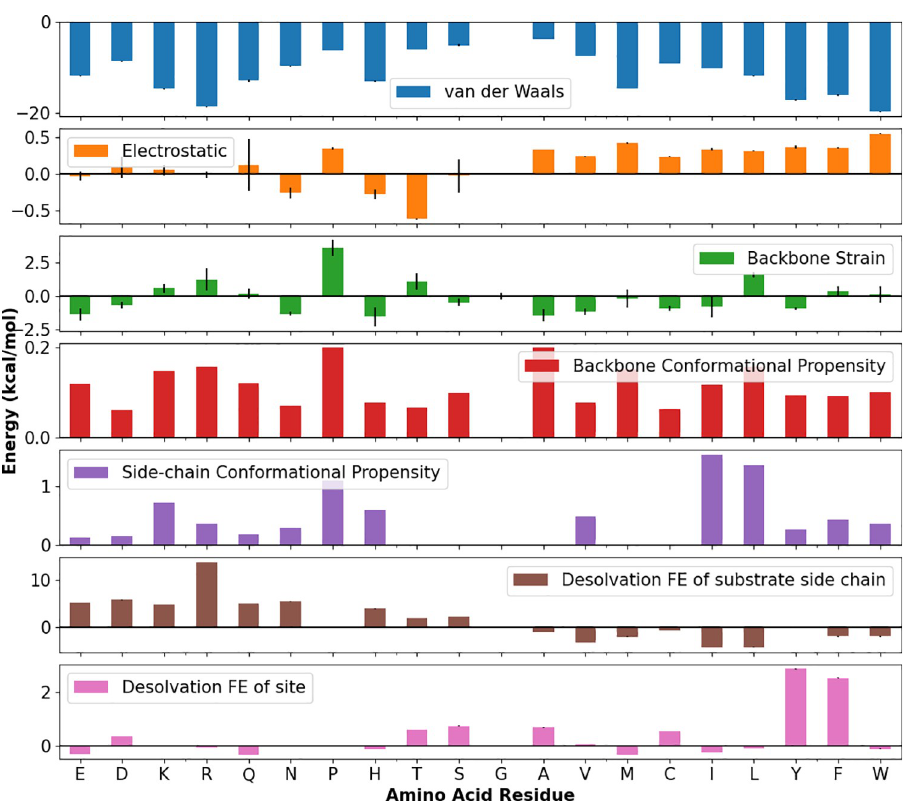
Fig 4. Individual, unscaled physical interaction terms for all possible substrate amino acid side chains occupying the site 0 in the SBD. Error bars are calculated as standard error of the mean. The residues are ordered by Wimley- White interfacial hydrophobicity scale to facilitate easy reading [37]. Error bars report standard error of the mean from the MD